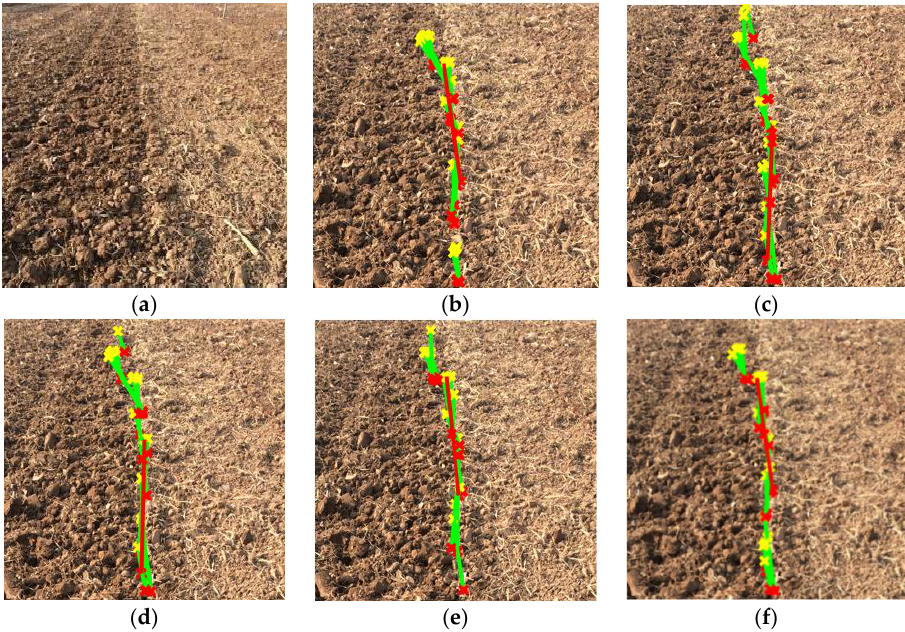
Figure 16. The longest line of the operators: ( a ) original; ( b ) Sobel; ( c ) Roberts; ( d ) Prewitt; ( e ) Log; ( f ) improved anti-noise morphology.